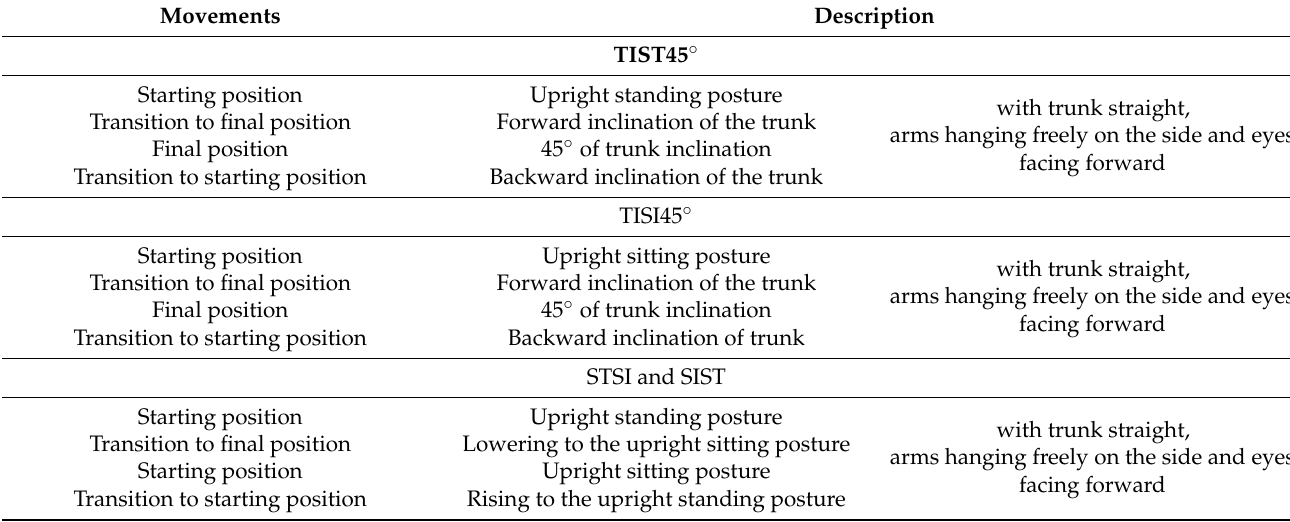
Table 2. A description of the movements performed during the experimental